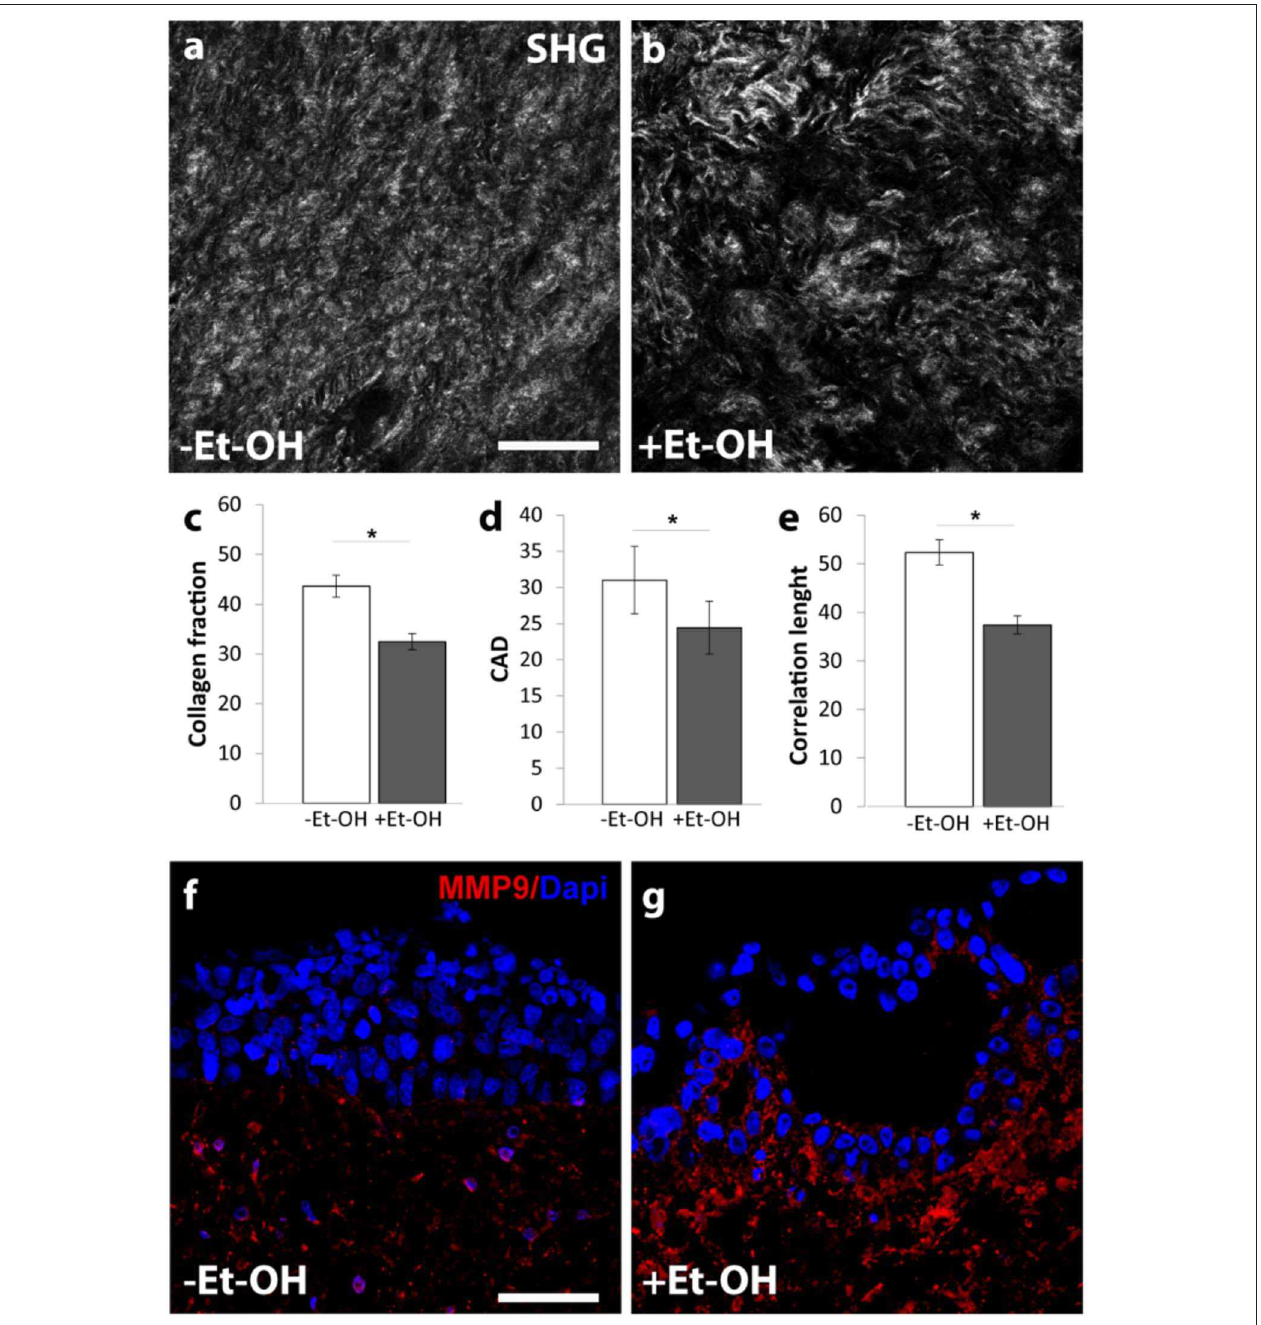
FIGURE 6 | Et-OH-induced 3D-HIM stromal injury. Representative high magnification SHG images (gray scale) of the auto-produced collagen in untreated (–EtOH) 3D-HIMs (a) and 400mM Et-OH-treated ( + Et-OH) 3D-HIMs (b) ; scale bar 75 µ m; (c) Collagen fraction, (d) CAD and (e) GLCM analysis in untreated (–EtOH) and 400mM Et-OH-treated ( + Et-OH) 3D-HIMs (* p < 0.001); immunofluorescence images indicate different protein expression stained in red (MMP9) on untreated (–EtOH) 3D-HIMs (f) and 400mM Et-OH-treated ( + Et-OH) 3D-HIMs (g) ; scale bar is 75 µ m; DAPI (blue fluorescence). All the experiments were performed in triplicate ( n = 3); values represent the mean and the standard